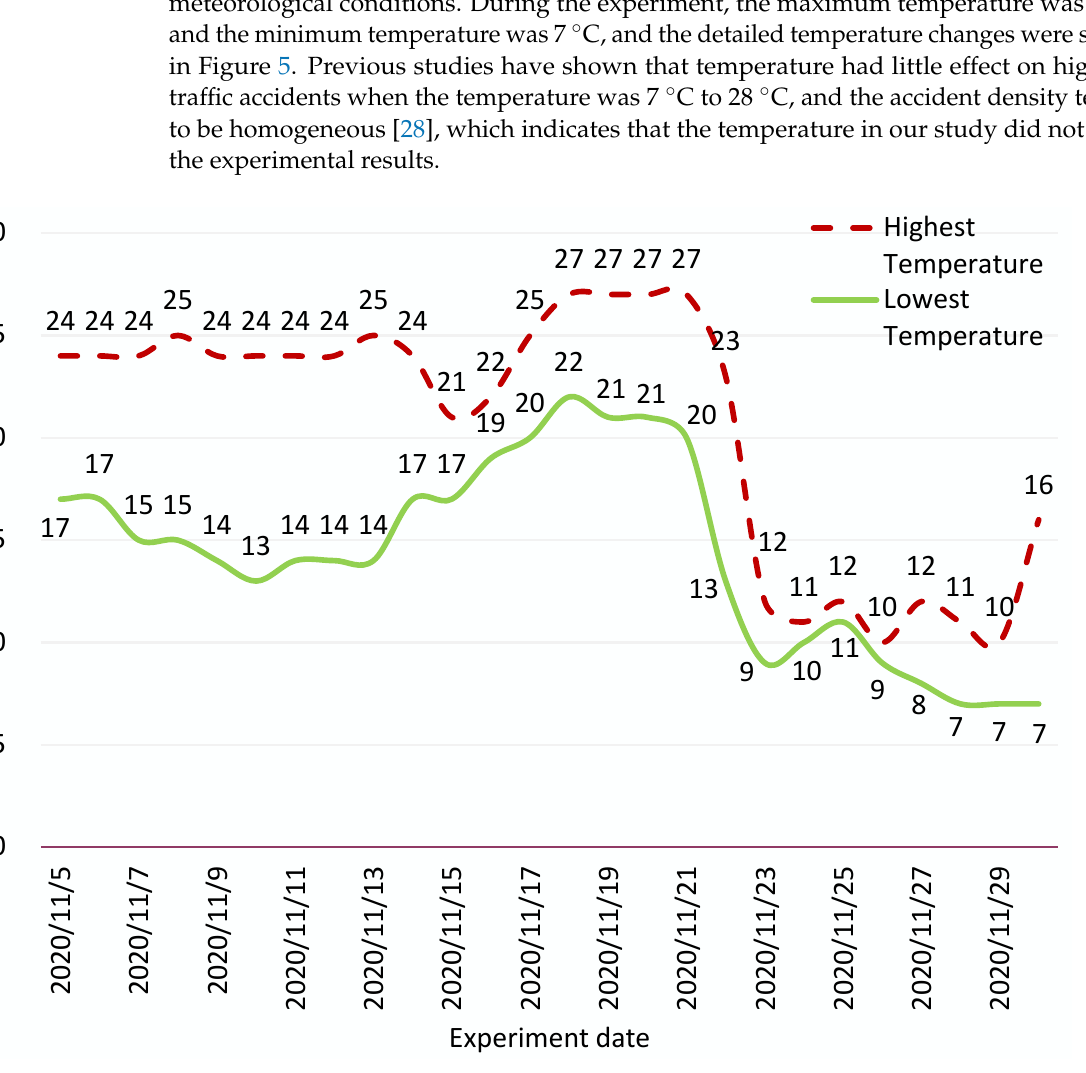
Figure 5. Experimental temperature changes across time. (Note: Red represents the daily highest temperature; green represents the daily lowest temperature).